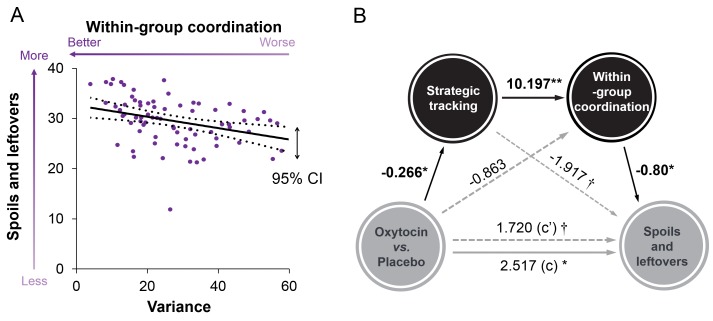
Oxytocin influences payment through its effects on strategic tracking and better within-group coordination.(A) Better coordination (i.e. lower within-group variance) associates with higher spoils and leftovers. (B) Oxytocin’s effect on attacker groups’ spoils from successful attacks and leftovers from attack failure is mediated by treatment effects on tracking α and better within-group coordination. Significant pathways were highlighted in bold. (* p < 0.05; ** p < 0.01).